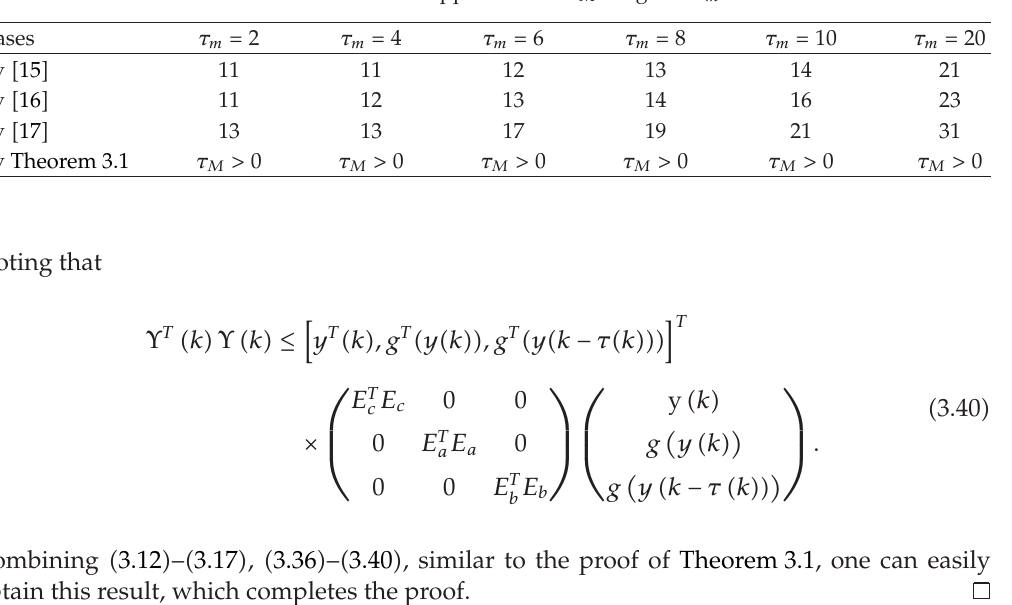
Table 1: Allowable upper bounds τ